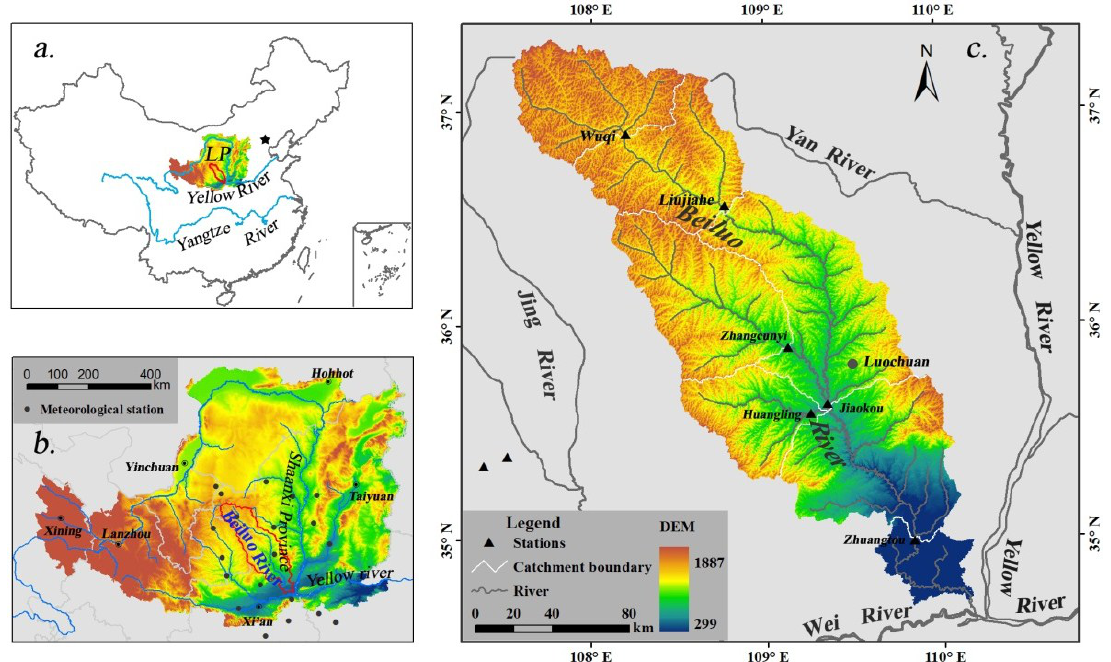
Figure 1. ( a ) The location of the Beiluo River basin and the Loess Plateau in China; ( b ) map of the Loess Plateau in the middle reaches of the Yellow River basin; ( c ) map of the Beiluo River basin.